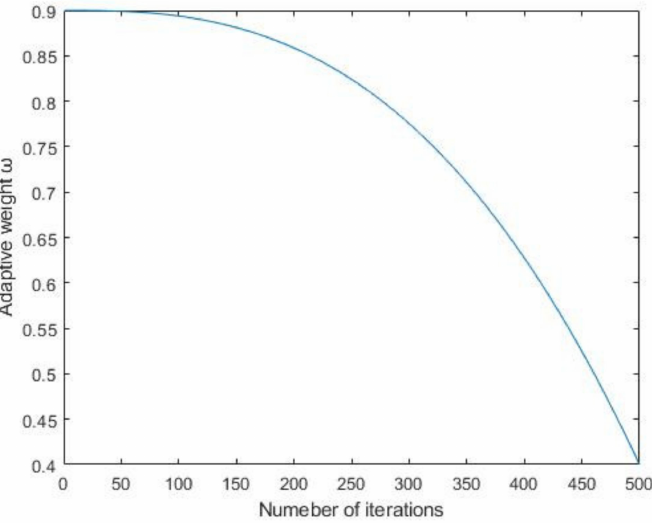
Figure 3. Adaptive